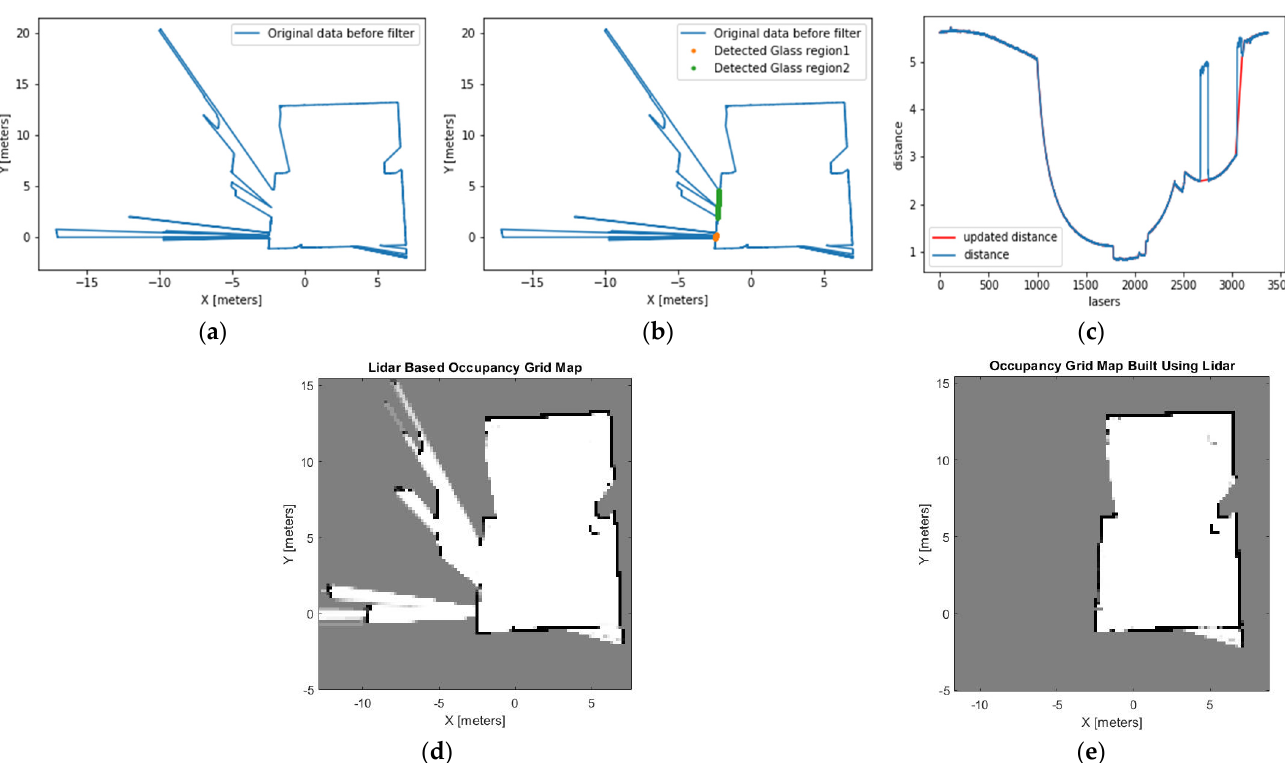
Figure 14. ( a ) A map built by the original LiDAR data shows no recognition of the presence of both glass in the room, ( b ) lasers that pass through the glass are identified and marked by the orange color, ( c ) the distance measurement is updated based on the two detected glass regions and presented in the red line, ( d ) the occupancy grid map built by using the original LiDAR data before the glass region is detected. This map shows the area beyond the glass region as a free space, ( e ) occupancy grid map built using the proposed method recognises the area beyond the glass as occupied